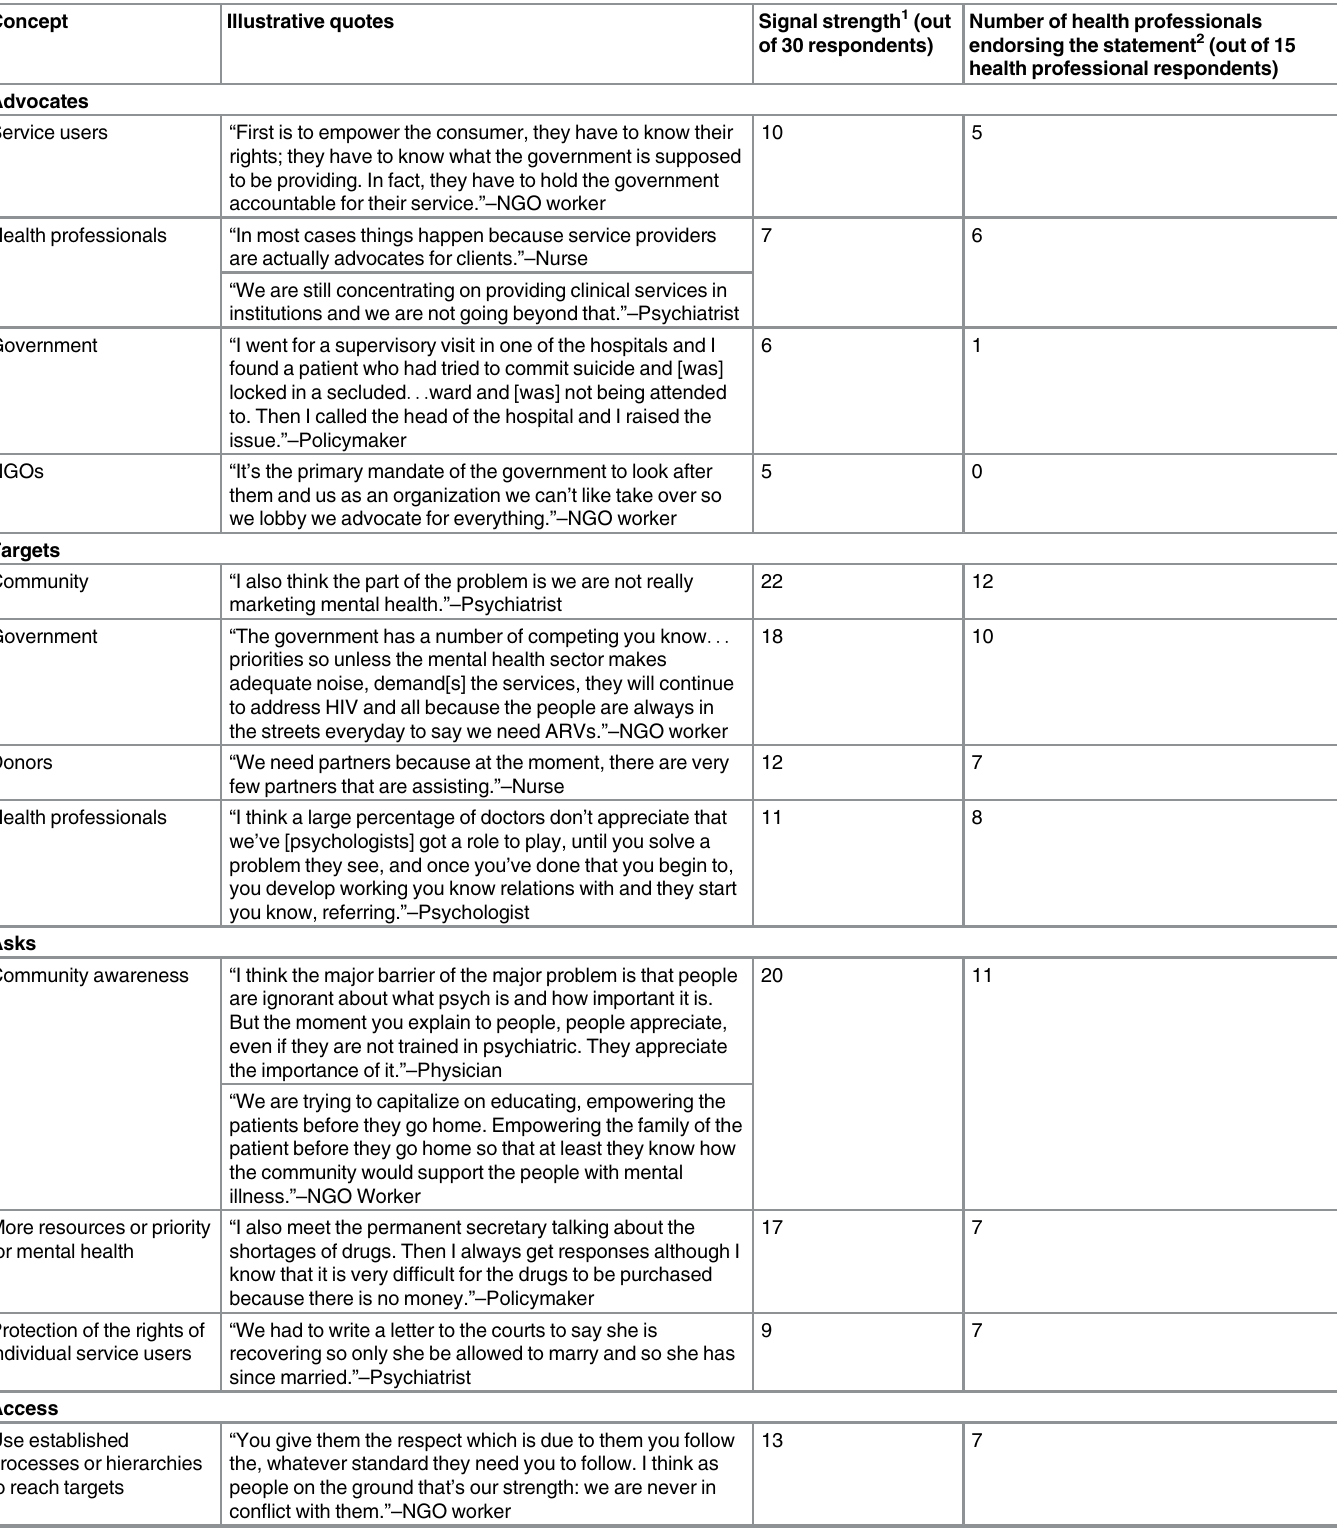
Table 3. Themes, illustrative quotes, and signal